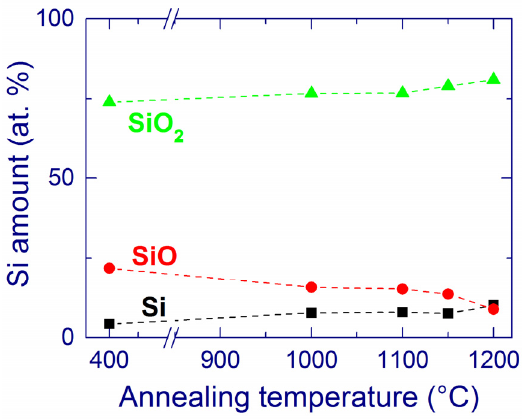
Figure 2. Composition of a SiO 1.7 film provided by X-ray photoelectron spectroscopy (XPS) as a function of the annealing temperature. Reproduced with permission from [116]. Copyright 2012, AIP Publishing LLC.